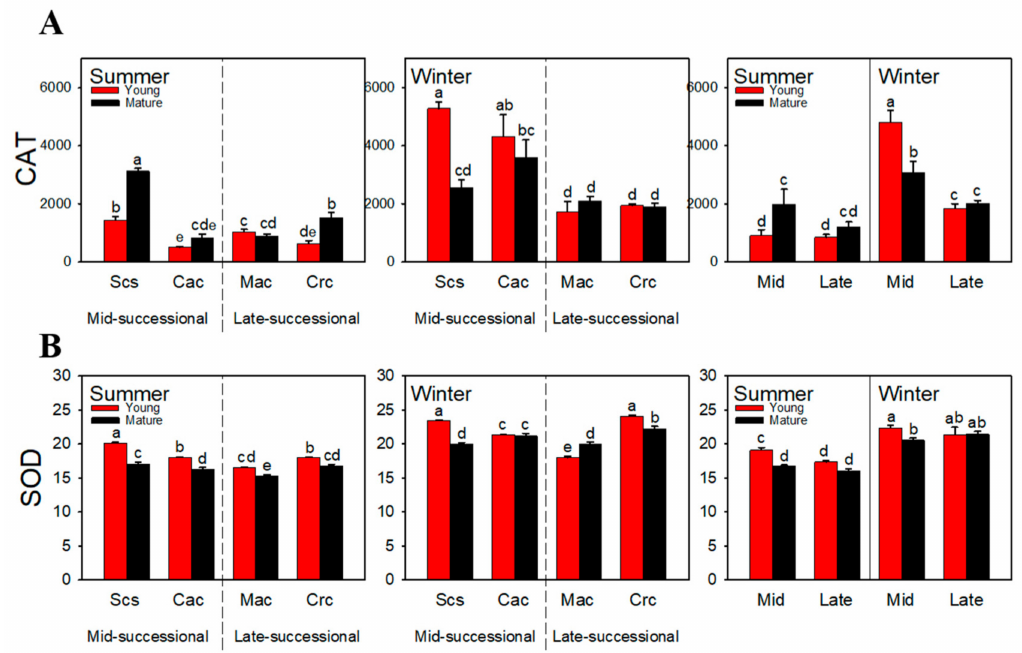
Figure 5. CAT ( A ) and SOD ( B ) activities of dominant species at different successional stages in different seasons. Scs, Schima superba ; Cac, Castanopsis chinensis ; Mac, Machilus chinensis ; Crc, Cryptocarya chinensis . Mid, mid-successional tree group; Late, late-successional species tree group. Different letters above bars indicate statistical significance ( p <